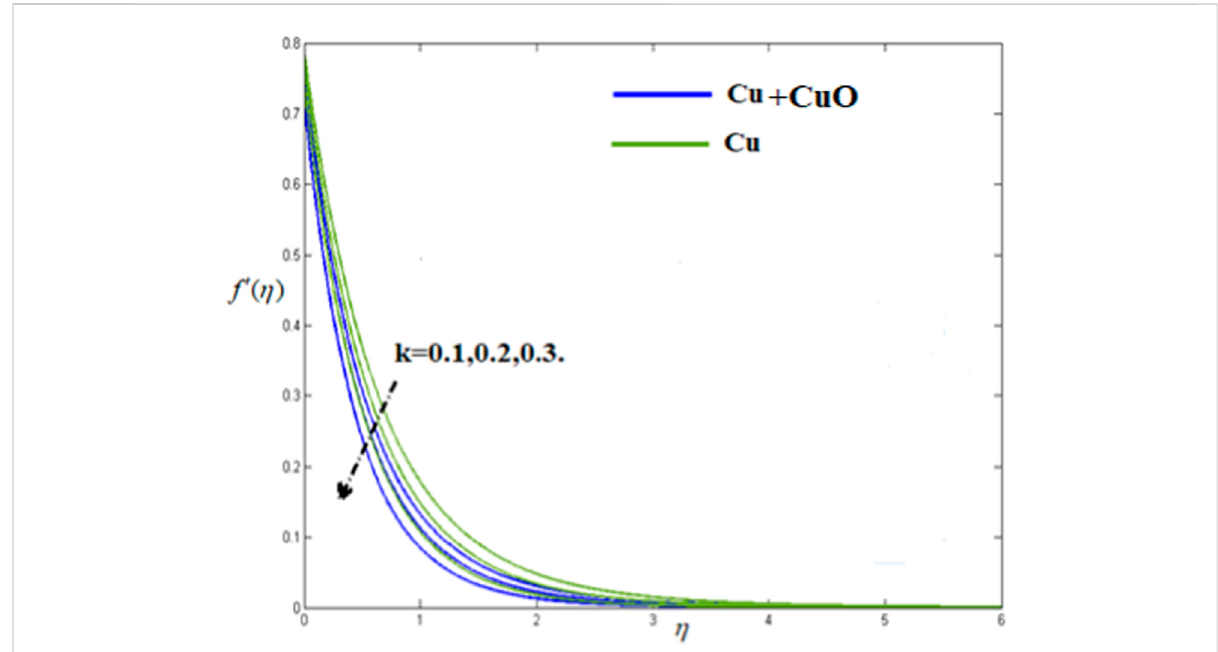
FIGURE 3 k versus f ′ ( η ) . When, ϕ 1 , ϕ 2 (cid:2) 0 . 02 , Λ (cid:2) 0 . 4 , Gr (cid:2) Gr * (cid:2) Rd (cid:2) 0 . 3 , B i (cid:2) 0 . 1 , Pr (cid:2) 6 .